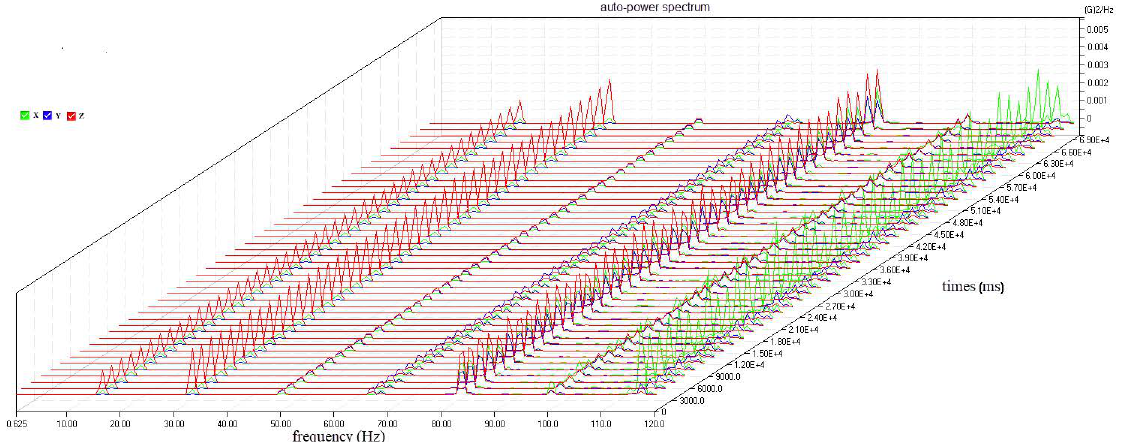
Figure 9. Waterfall diagram of the auto-power spectrum for an unbalanced blade pitch.